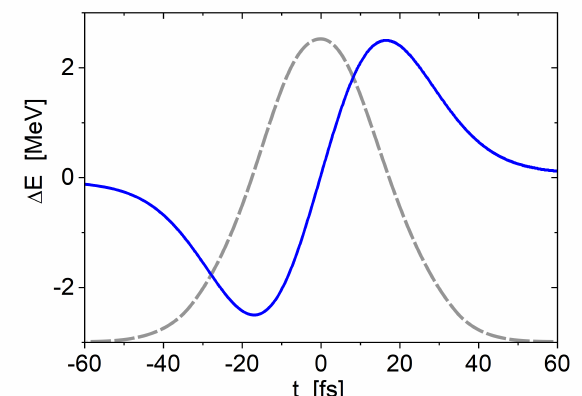
Figure 2. Energy chirp along electron bunch induced by the longitudinal space charge field (blue curve) as it was used for the chirped 3D simulation. The grey dashed curve shows the longitudinal profile of the electron